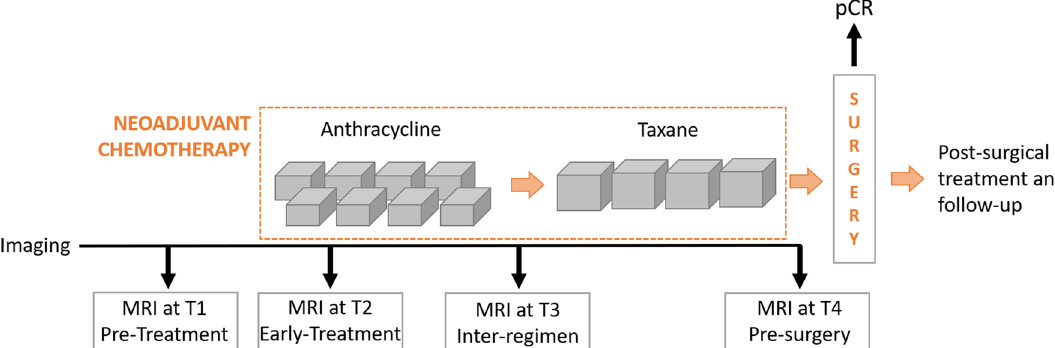
Figure 1. Chart of the MRI acquisitions for patients of the I-SPY1 TRIAL dataset undergoing neoadjuvant chemotherapy. Pre-treatment and early-treatment exams (MRI at T1 and MRI at T2, respectively) were analysed for the prediction of pathological Complete Response (pCR). The final treatment evaluation was performed at the end of chemotherapy and after the surgery by pCR.